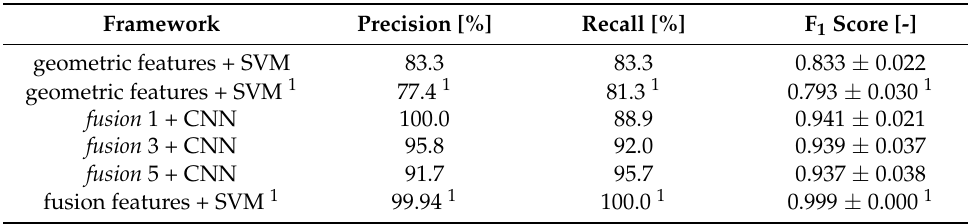
Table 5. The performance of different